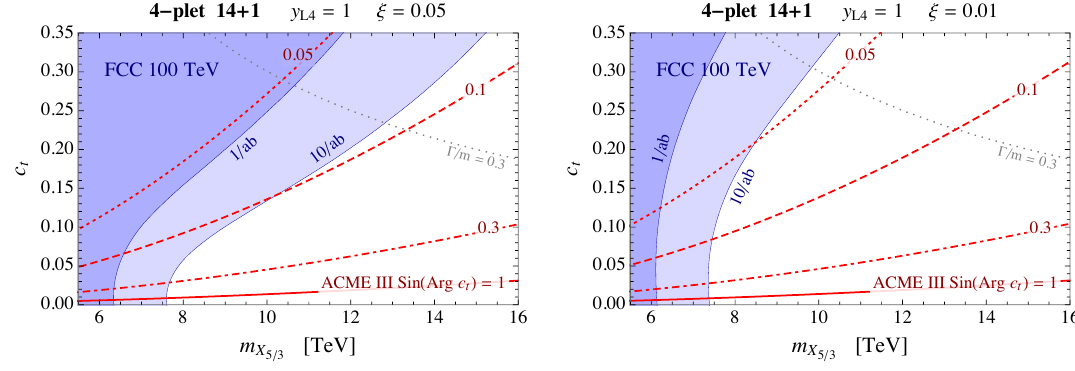
Figure 8 . Future direct and indirect exclusion bounds on the c t coupling as a function of the mass of the X resonance for the scenario with a light fourplet in the 14 + 1 model (for the choice 5 = 3 y L 4 = 1). The left and right panels correspond to (cid:24) = 0 : 05 and (cid:24) = 0 : 01 respectively. The direct bounds from top partners searches at FCC-hh are given by the blue shaded regions (for integrated luminosities 1 = ab and 10 = ab). The red lines correspond to the indirect exclusions for the estimated ACME III